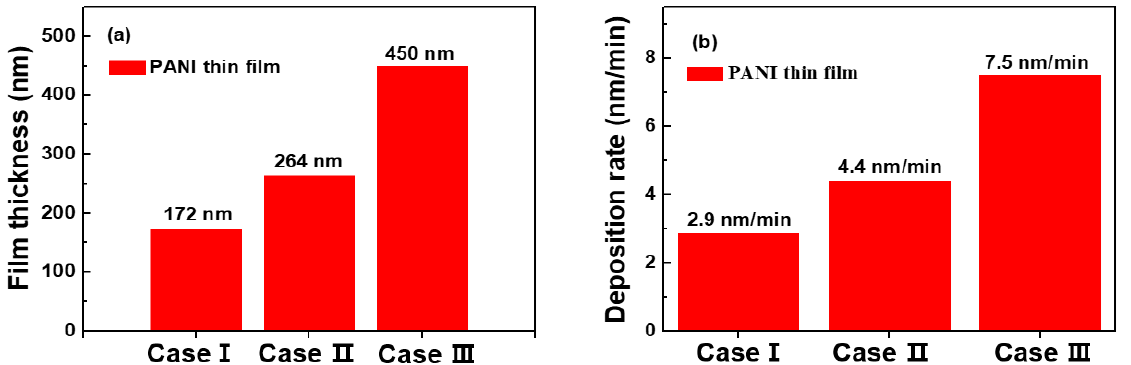
Figure 7. ( a ) Film thickness and ( b ) deposition rate of PANI thin film prepared by APPR with pin electrode under optimal conditions when using three electrode configurations (cases I, II, and III).